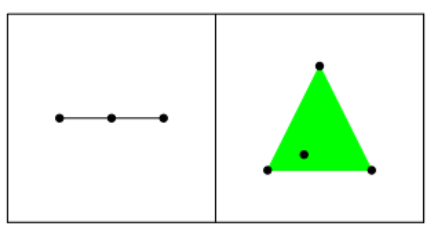
Figure 8. Convex hulls.